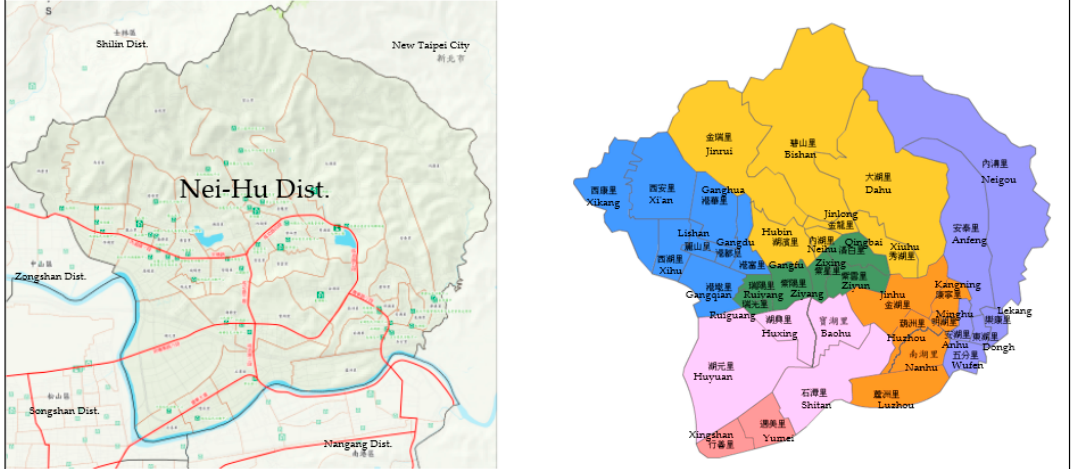
Figure 2. Nei-Hu District disaster prevention map for 39 neighborhoods’ evacuation routes. Source: prevention map by Taipei City Government.